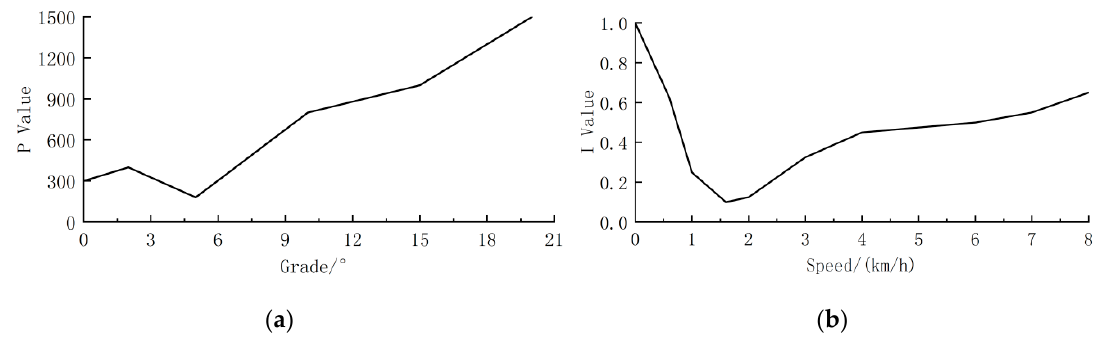
Figure 11. Map of p -value and I -value: ( a ) p -value Curve with Grade; ( b ) I -value Curve with Speed.